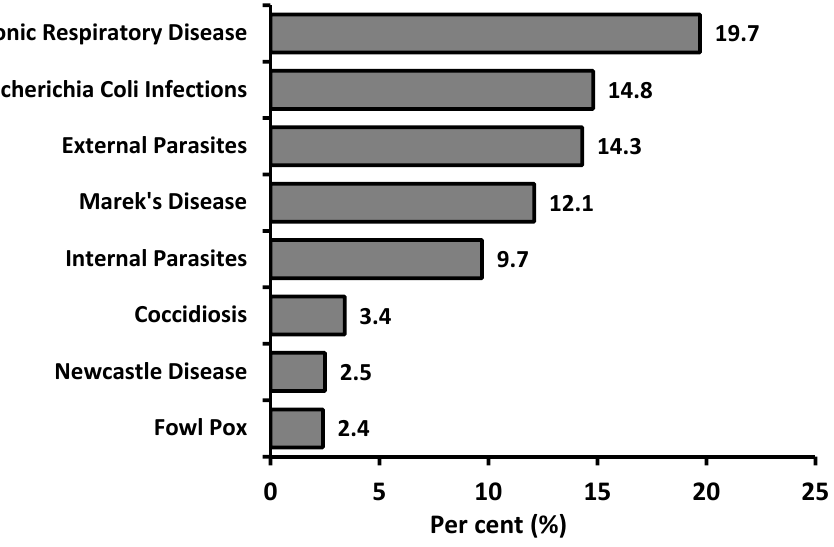
Figure 5. The most common poultry diseases reported by the respondents.